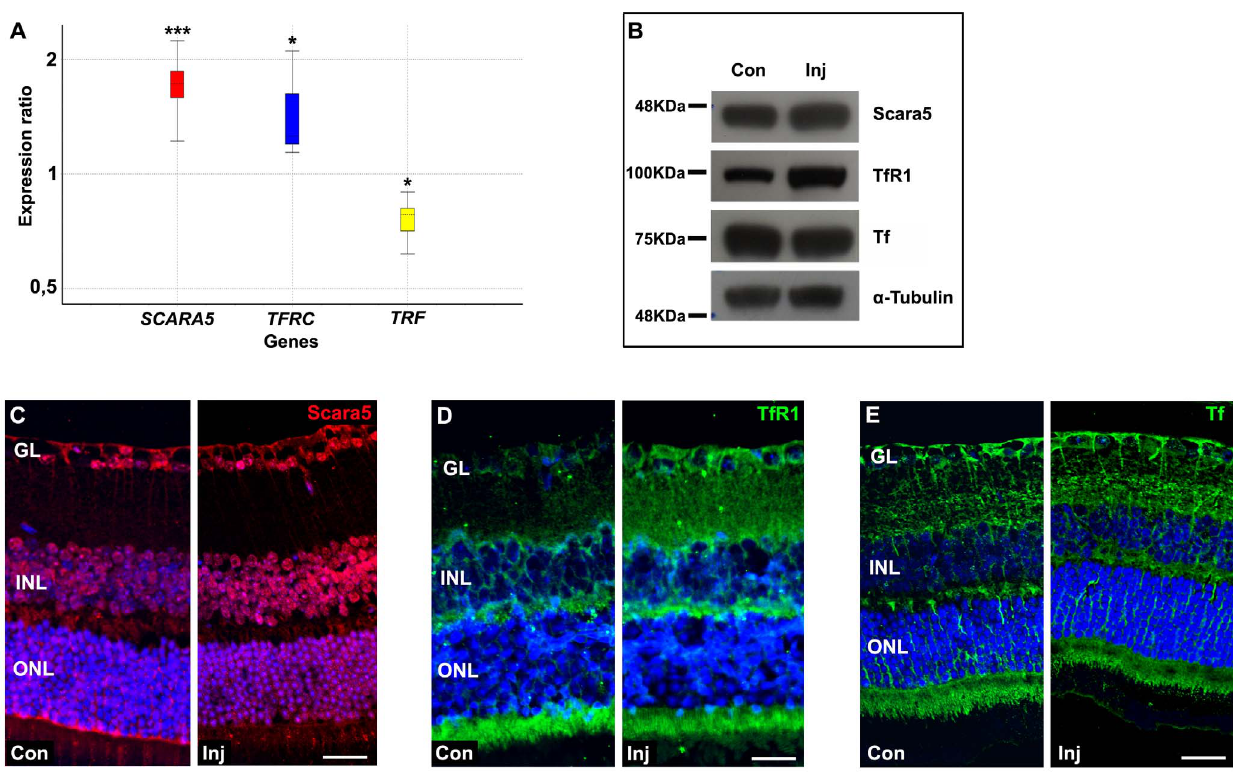
Figure 8. HSF influx into the retina changed Scara5, TfR1, and transferrin gene and protein expression. A: Relative expression of SCARA5 , TFRC , and TRF obtained from q-RT-PCR analysis. Y-axis indicates the relative expression distribution of a ratio of injected mice retinas versus non-injected control mice retinas with ACTB and GAPDH as housekeeping genes. Boxes represent interquartile range, the median value is indicated by horizontal dotted line, and whiskers represent the minimum and maximum observation. Statistical significance calculated by Rest 2009 (http:// www.REST.de.com) is indicated by *p , 0,05, and ***p , 0,001 (n=12). Ratios over one indicate genes ( SCARA5 and TFRC ) with higher expression in injected mice retinas relative to non-injected control mice retinas, and ratio less than one indicates gene ( TRF ) with lower expression in injected mice retinas opposed to non-injected control mice retinas. Western blotting and immunohistochemistry analyses confirmed that HSF accumulation in the retina was accompanied with an increased expression of Scara5 and TfR1 (B,C,D), and a slightly decrease of transferrin (B,E). Nuclei were counterstained with ToPro3. Con, non-injected control; Inj, injected; GL, ganglion cell layer; INL, inner nuclear layer; ONL, outer nuclear layer. Scale bars: 25 m m (C); 28 m m (D); 30 m m